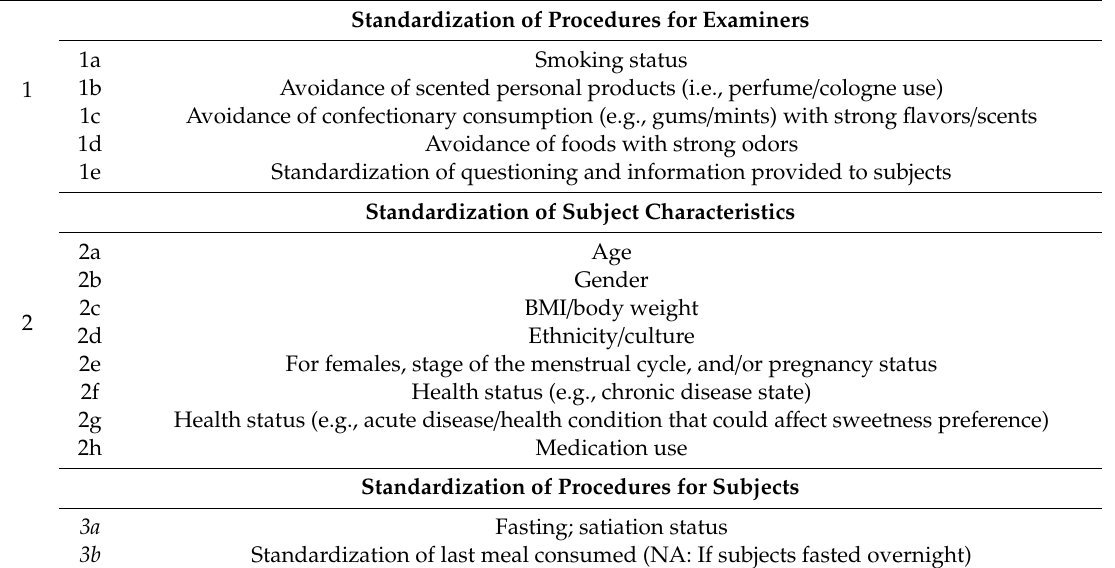
Table 1. Outline of parameters included in the “investigator